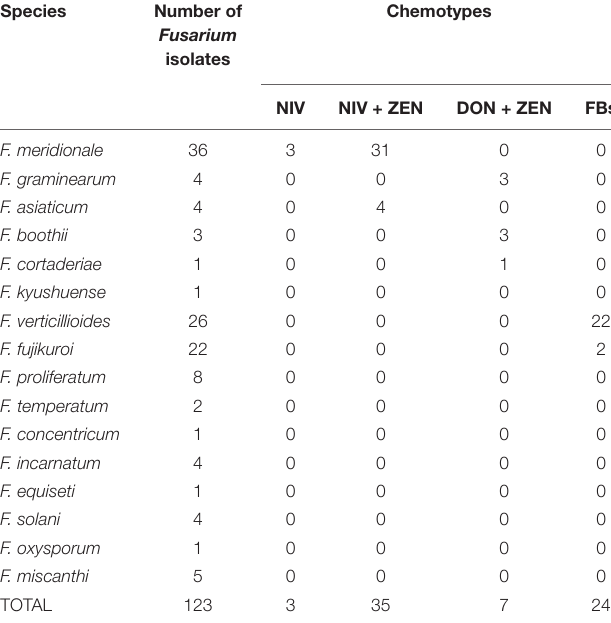
TABLE 2 | The chemotypes of 123 Fusarium isolates identified by PCR amplification.